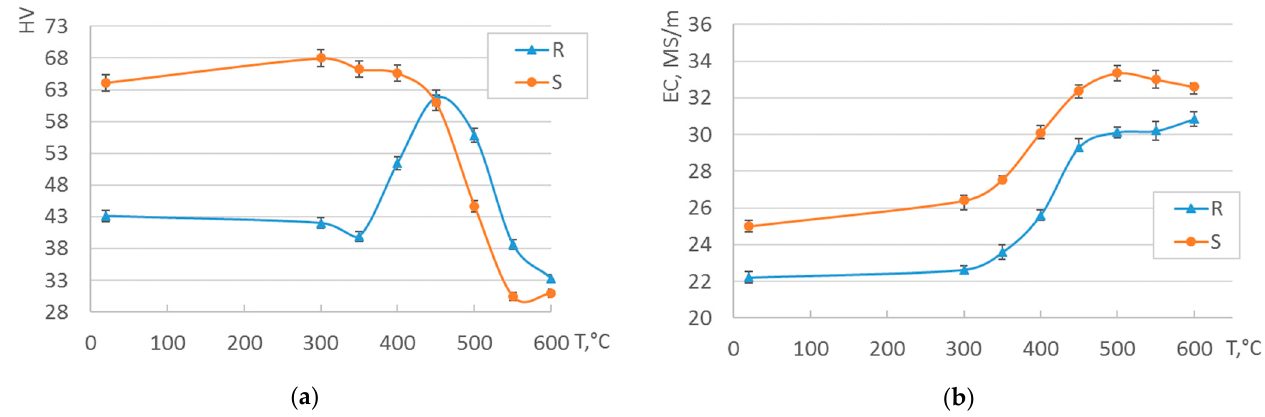
Figure 4. ( a ) Hardness (HV) and ( b ) electrical conductivity (EC) curves for EMC rod (R) and cold rolled strip (S) subjected to stepwise annealing in accordance with the processing route shown in Table 2 (see R (temperature)/S (temperature) designation).